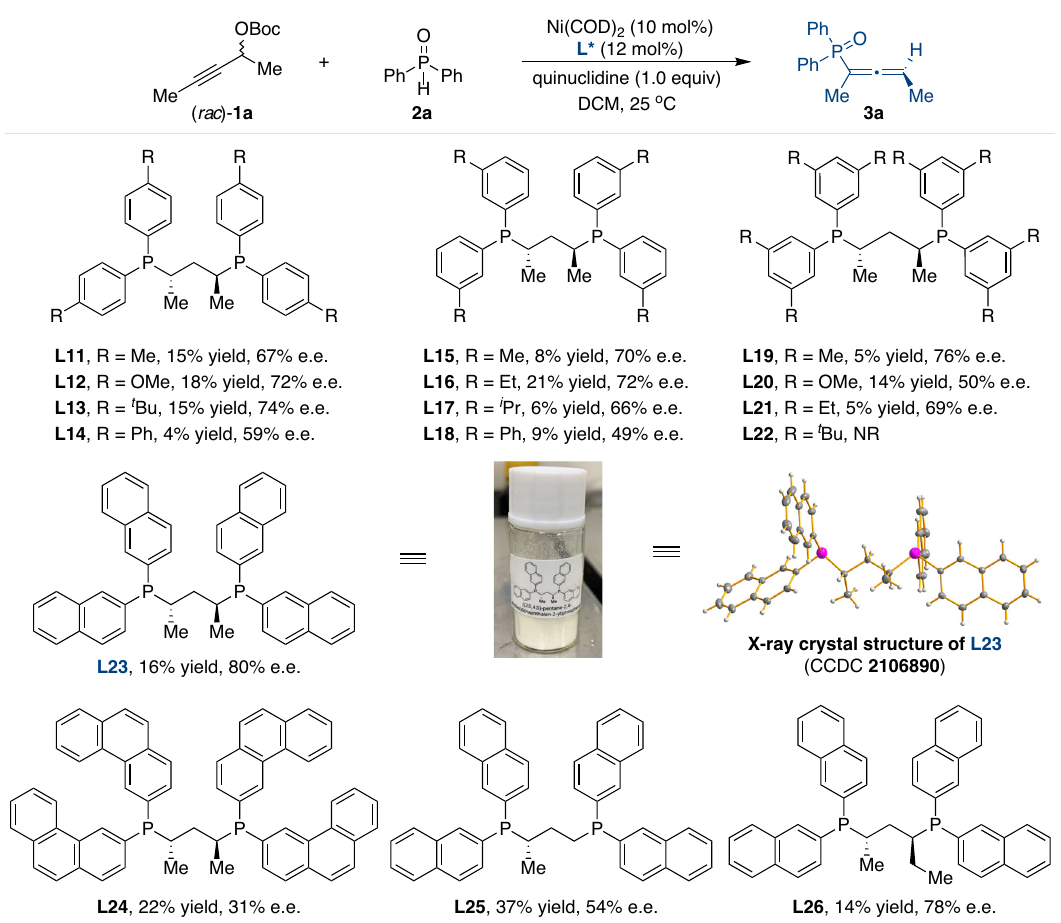
Fig. 2 | Investigation of BDPP-type ligands in enantioselective allenylation. Reactions were conducted by using Ni(COD) 2 (10mol%), L* (12mol%), ( rac )- 1a (0.3mmol), 2a (0.1mmol), and quinuclidine (1.0 equiv) in DCM (1mL) at 25°C for